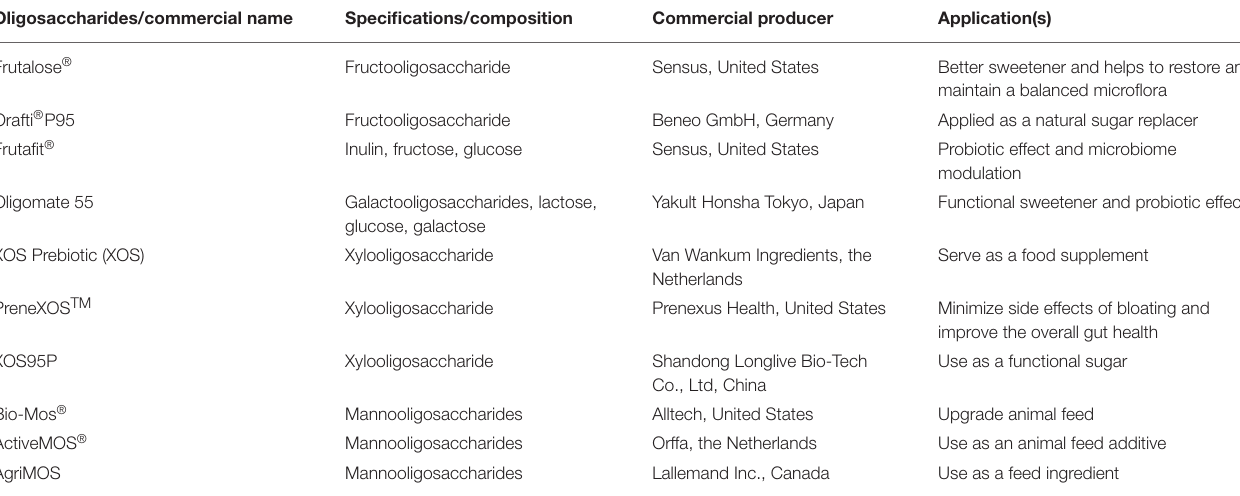
TABLE 1 | Some of the commercially produced prebiotic oligosaccharides and their uses.